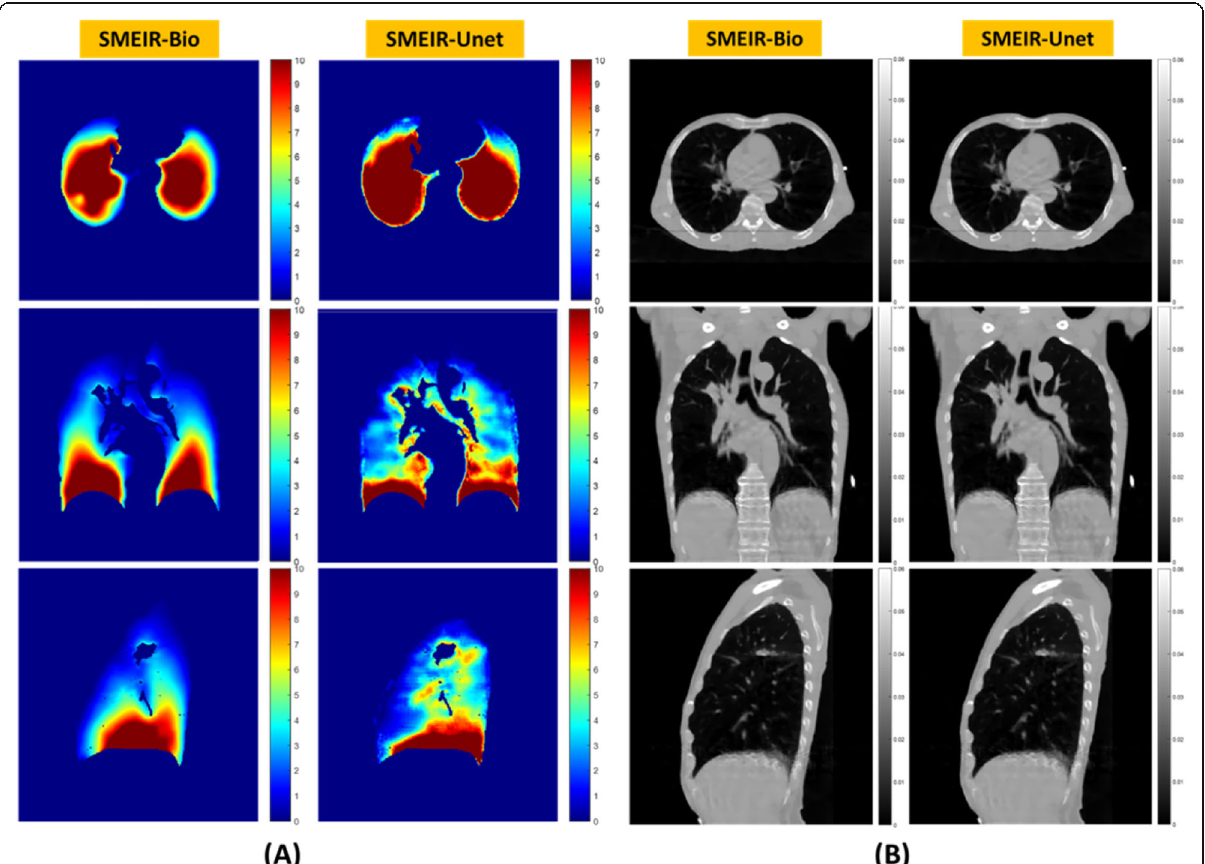
Fig. 7 Comparison of DVFs solved by the SMEIR-Bio and the SMEIR-Unet techniques ( a ); Comparison of the corresponding motion-compensated CBCT images reconstructed by the SMEIR-Bio and the SMEIR-Unet techniques ( b ). The DVFs were from the same patient case as Fig. 6, and shown at the same slice locations. SMEIR: Simultaneous motion estimation and image reconstruction; CBCT: Cone-beam computed tomography; SMEIR-Bio: Biomechanical modeling-guided SMEIR; SMEIR-Unet: SMEIR with U-net based DVF fine-tuning; DVF: Deformation-vector-field DVF fine-tuning from biomechanical modeling or con- volutional neural network-based conversion, the SMEIR algorithm suffered from the largest DVF error, with the mean vector DVF error around 5 mm. The SMEIR-Bio and SMEIR-Unet techniques achieved appreciable re- ductions of the DVF errors, with the mean vector DVF error < 3.5 mm for both methods. Compared with